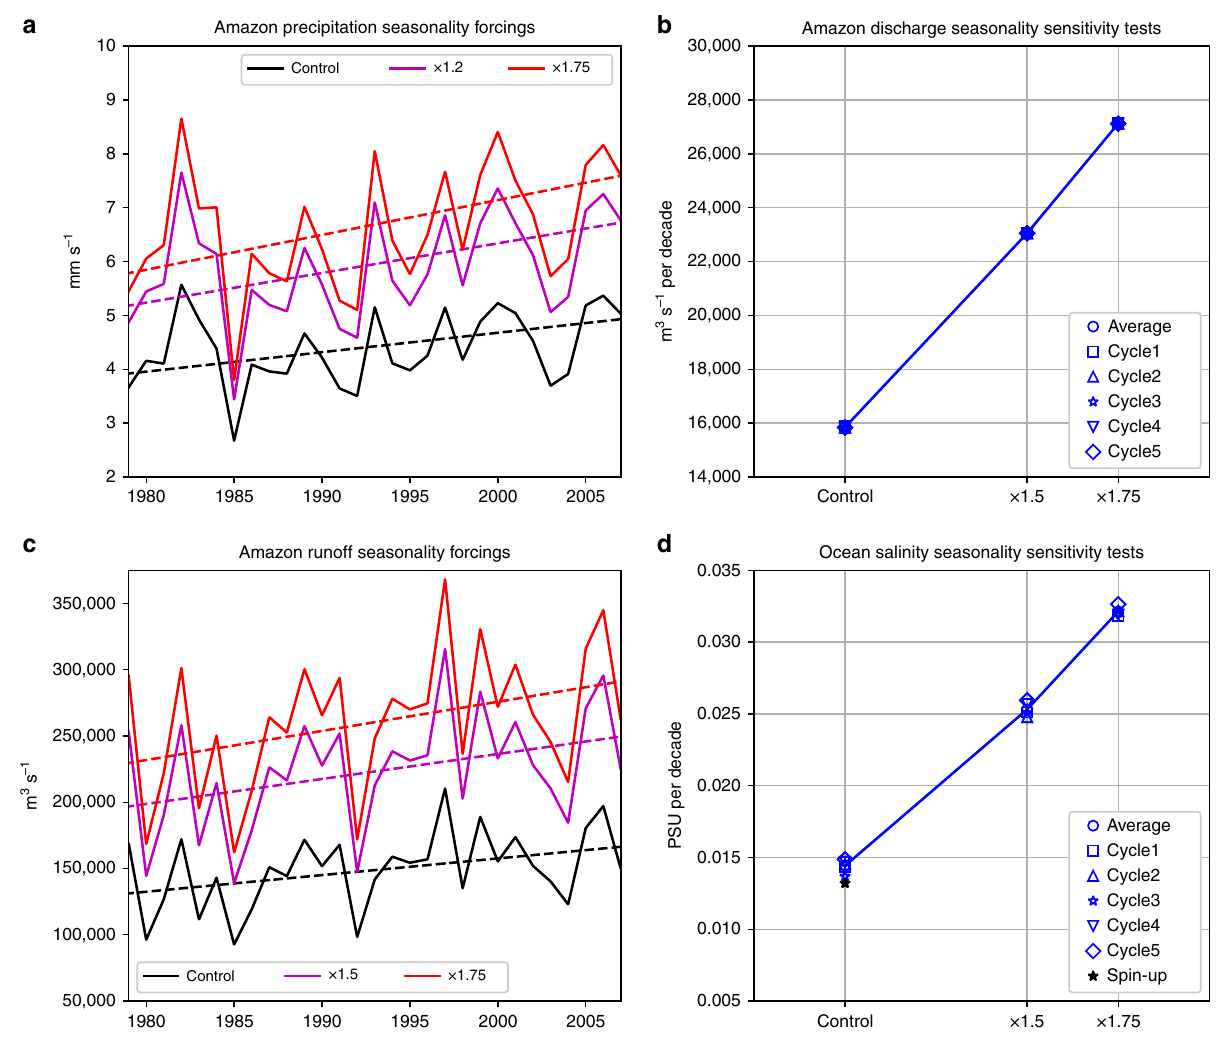
Fig. 4 Sensitivity of Amazon river discharge and Amazon plume region (APR) ocean salinity in response to seasonality changes in Amazonia precipitation and Amazon river runoff forcings in global land and ocean models. a The seasonality in the precipitation forcing used in the global land model control and experimental simulations. b Seasonality changes in Amazon river discharge in the land model experiments. c similar to a , but for Amazon river runoff forcing used to force the ocean model experiments. In a , c , the dashed lines are the linear fi ts used to determine trends. d similar to b , but for seasonality changes in APR ocean salinity in the ocean model experiments. The black star is the APR salinity seasonality trend, averaged over fi ve spin-up